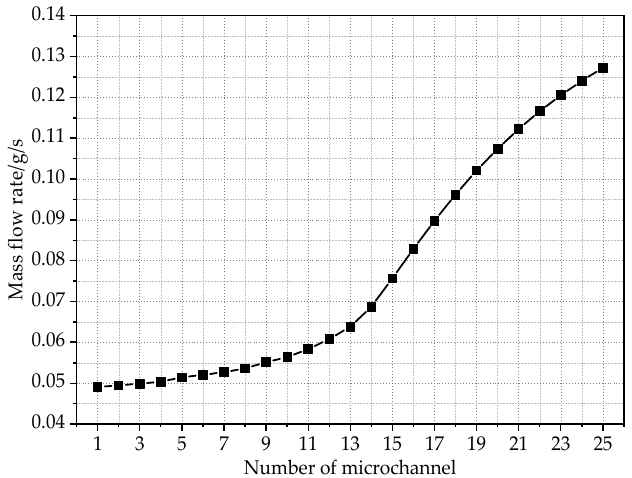
Figure 13. Mass flow rate of the refrigerant in the microchannels.